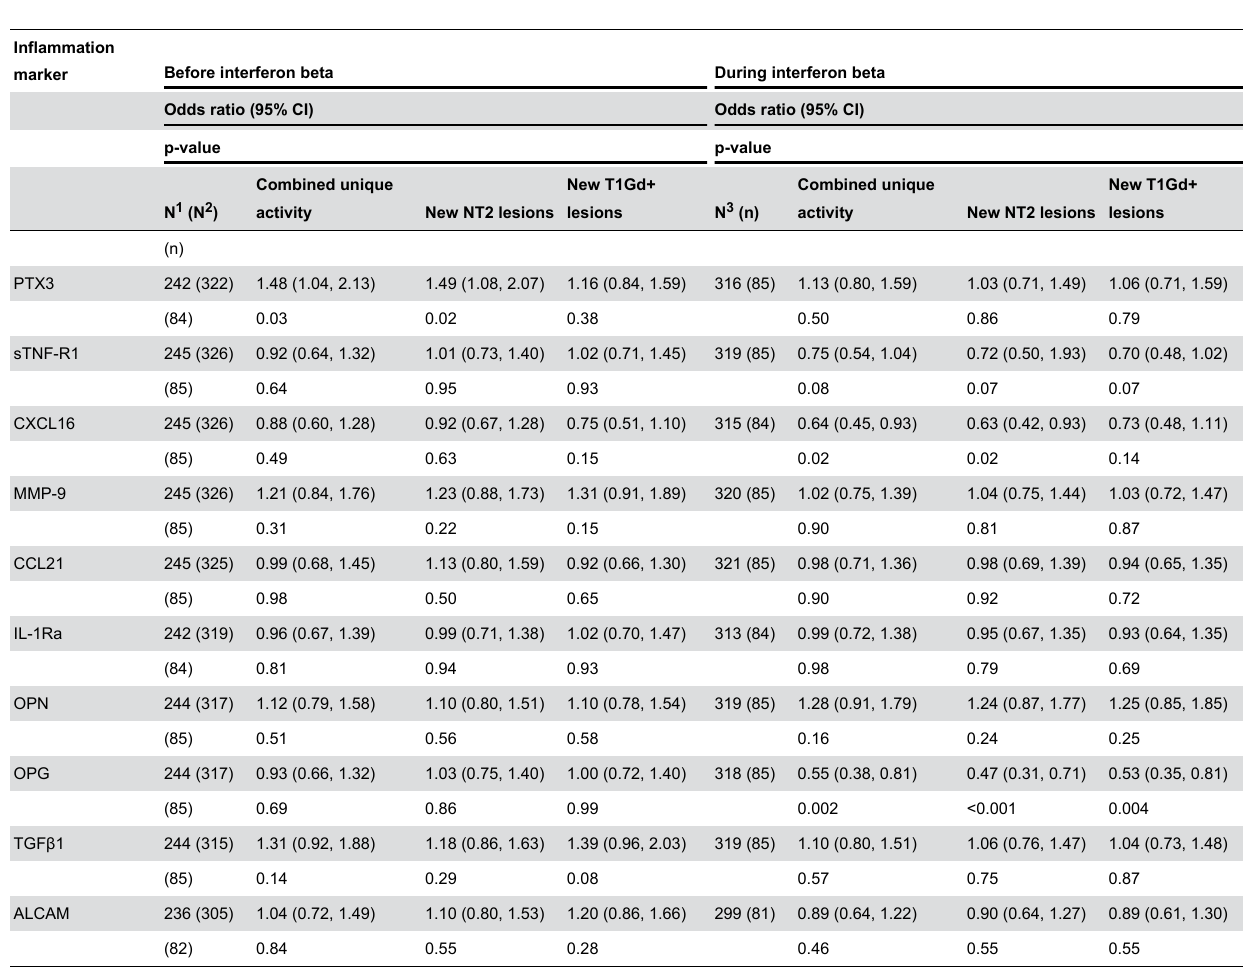
Table 3. Odds ratios for simultaneous MRI activity for each 1 SD increase in each inflammation marker before and during interferon beta